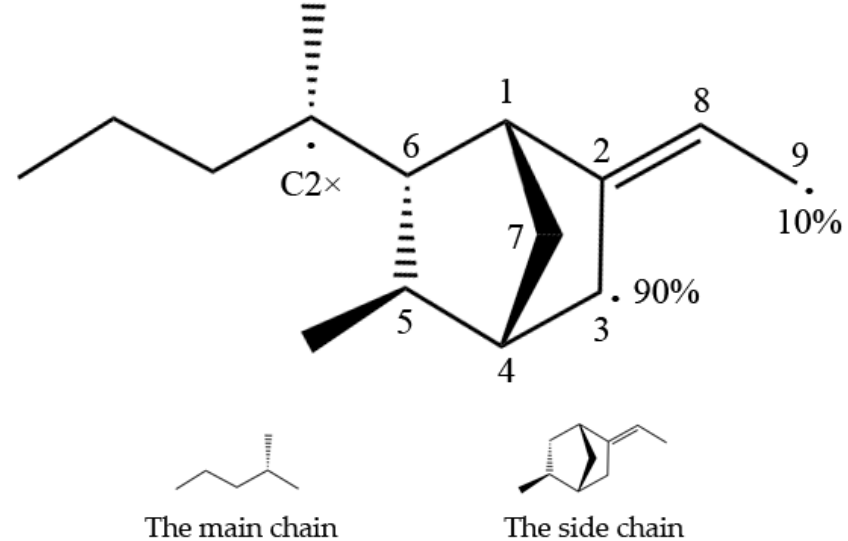
Figure 1. The active positions of ethylene-propylene-diene monomer (EPDM) free groups. The active position on the main chain is C2×, and the active positions on the side chain are C3 and C9. The reaction rate of C3 in the monomer is 90%, while C9 is only 10%.